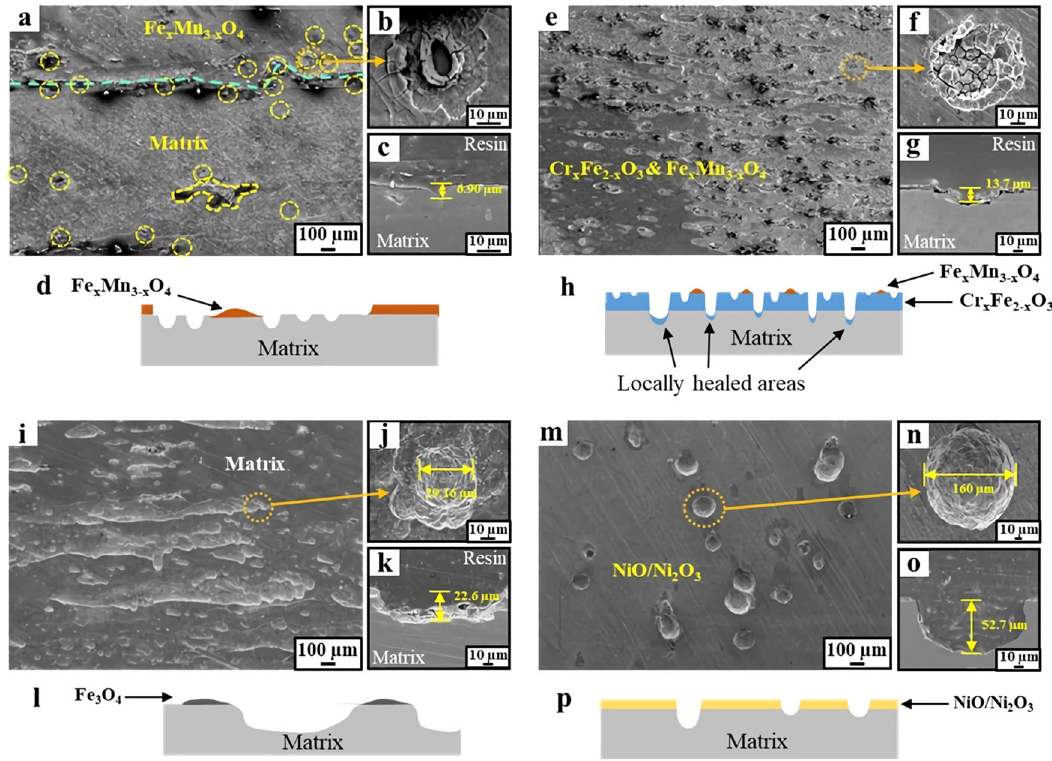
Fig. 6 FE-SEM images and simpli fi ed cross-sectional schematics of the samples. a – d H_Mn. e – h H_Mn-L_Cr. i – l API X70. m – p 9Ni. a , e , i , m Surface morphologies with low magni fi cation. b , f , j , n Magni fi ed view of damaged areas in the surfaces. c , g , k , o Cross-sectional view of damaged areas. d , h , l , p Simpli fi ed cross-section schematics showing their damaged